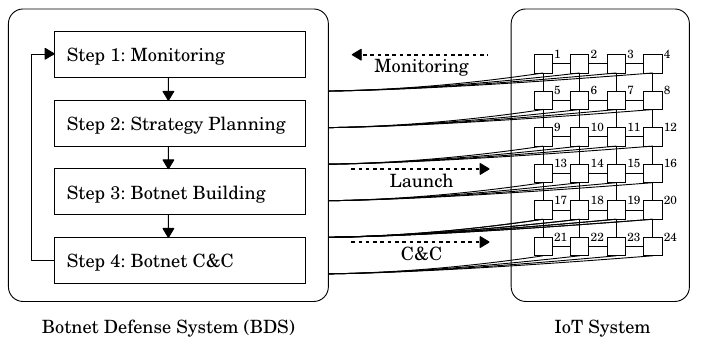
Figure 2. System configuration of